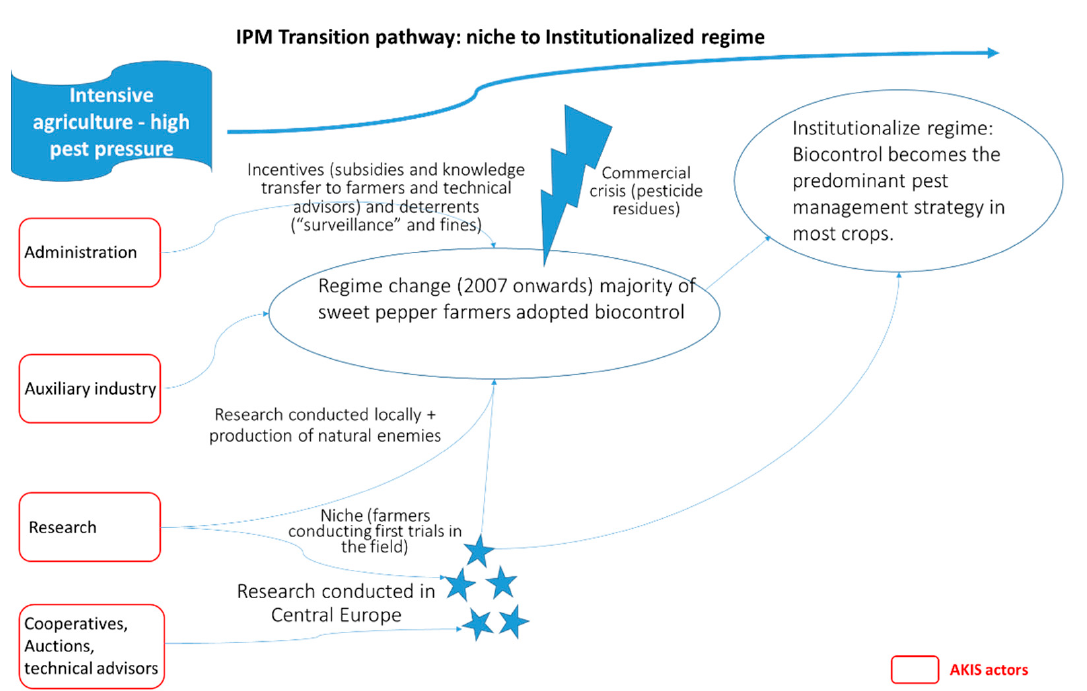
Figure 3. AKIS and IPM transition pathway (authors’ elaboration).